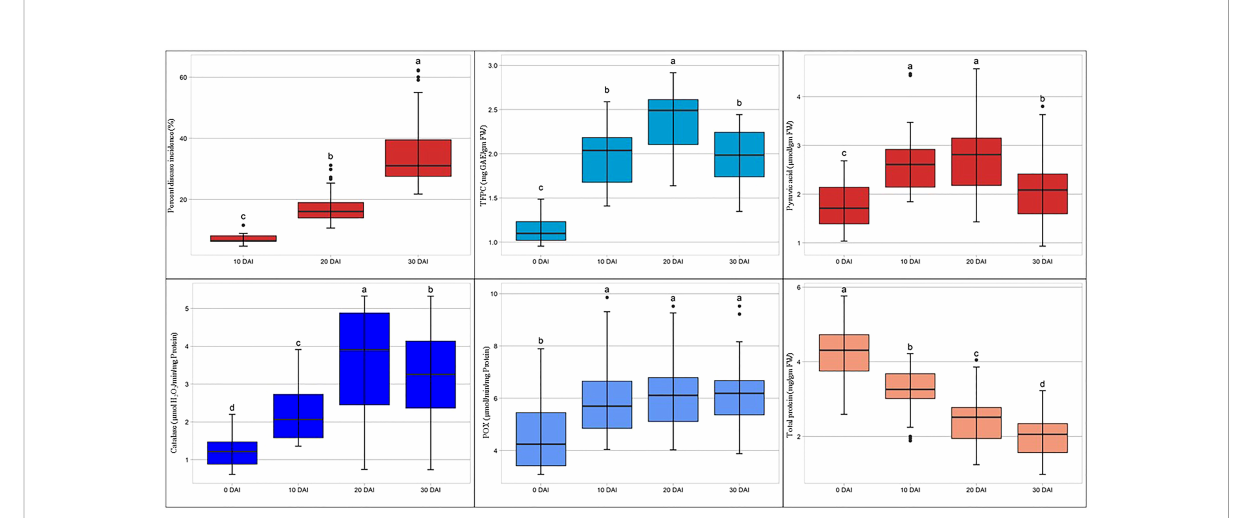
FIGURE 7 Box plot representation for mean activity of biochemical compounds, before inoculation and after different days intervals.